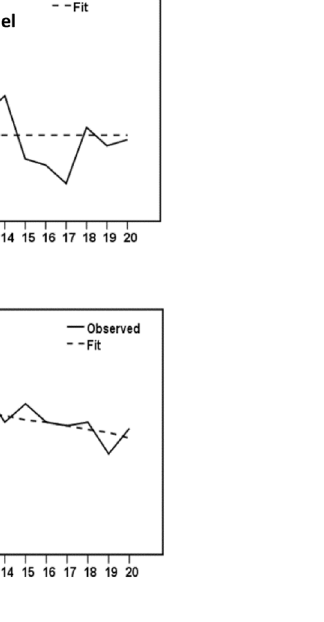
Fig 5. Time Series Analysis: Experiment 2. Time series sequence plots mean exit nodes in Experiment 2.